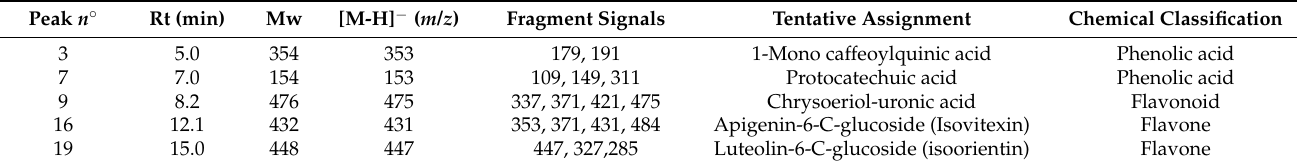
Table 2. Major phytochemical compounds identified in the leaves extract (LE).